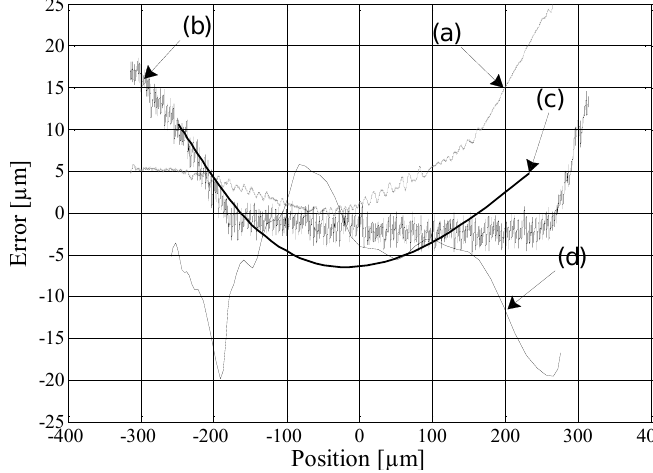
Figure 12. Simulated and experimental static position errors. Simulated: (a) modulation, (b) DCM; Experimental: (c) modulation, (d)